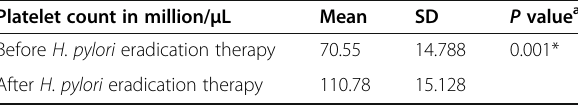
Table 2 Platelet count before and after H . pylori eradication therapy ( N = 63) Platelet count in million/ μ L Mean SD P value a